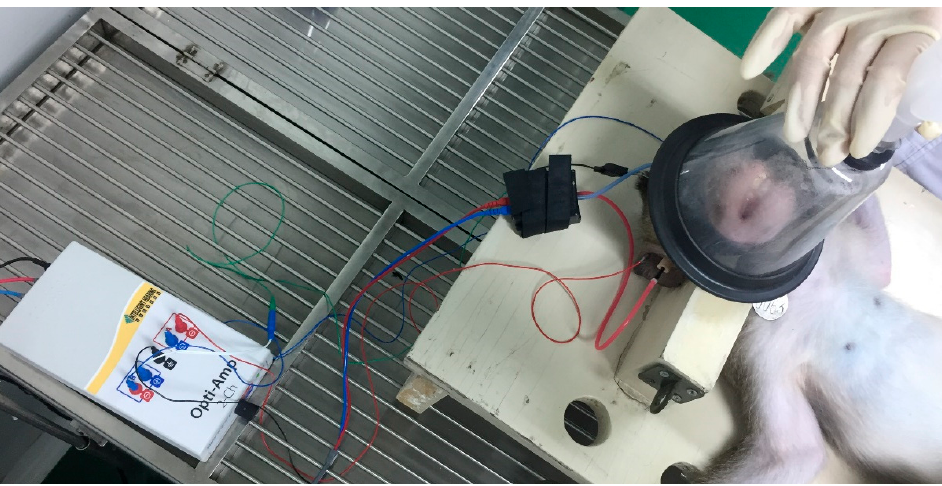
Figure 1. Experimental photos of ABR detection .